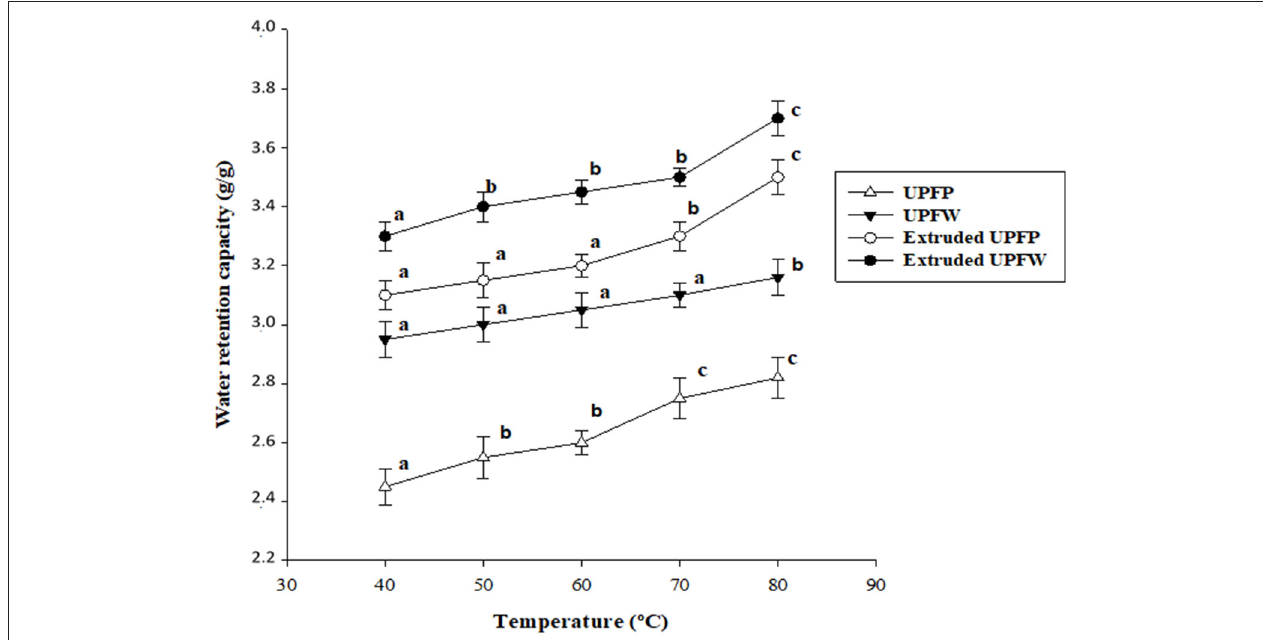
FIGURE 4 | Solubility at different temperatures of native and extruded flours of unripe plantain pulp (UPFP) and whole fruit (UPFW). Different superscript letters on the same curve indicate statistically significant differences ( P < 0.05).